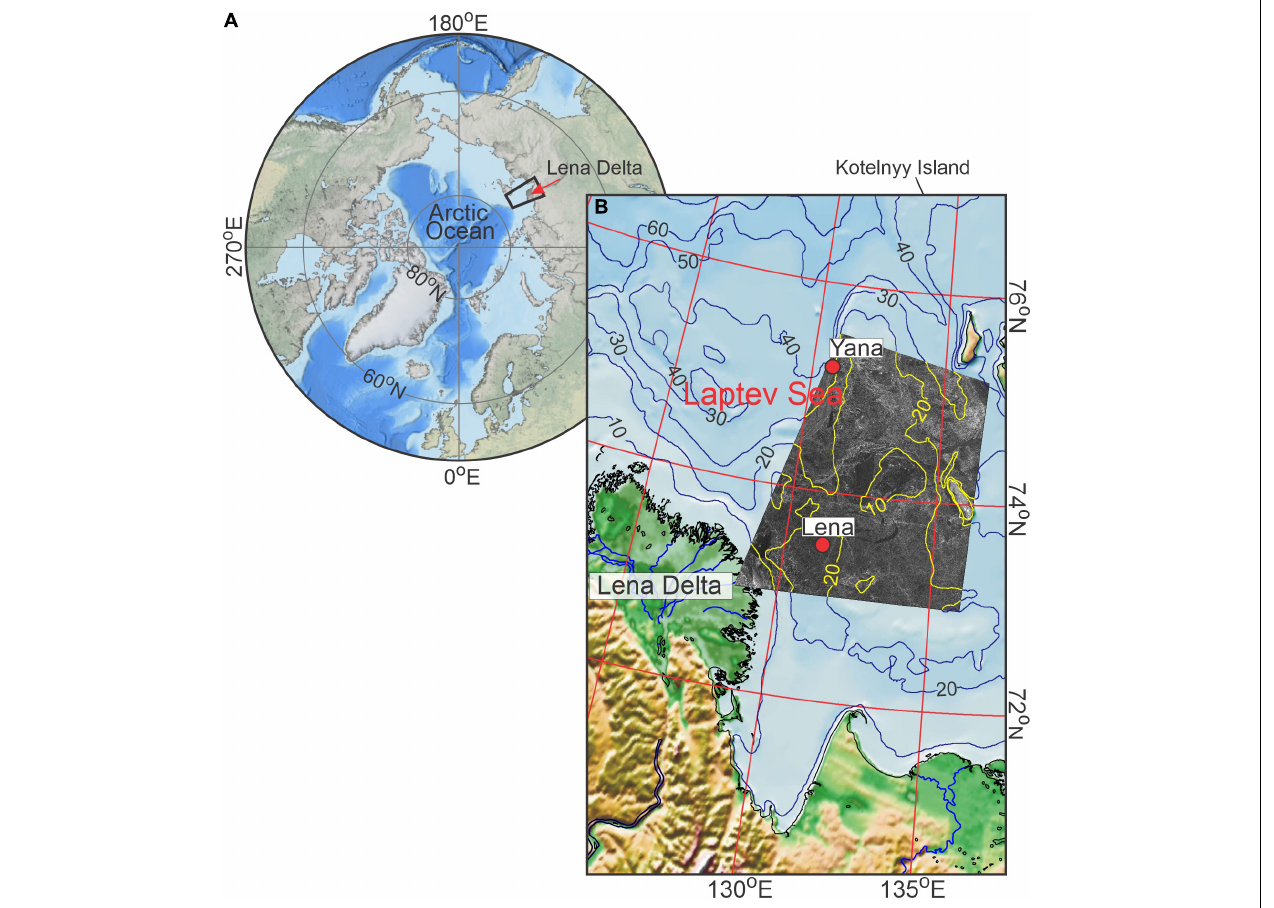
FIGURE 1 | (A) Location of the eastern Laptev Sea in the Arctic Ocean depicted by the black rectangle with the Lena River Delta indicated by the red arrow. (B) Bathymetry of the eastern Laptev Sea shelf with overlaid RADARSAT-1 satellite image from 26 March 1999. Red dots mark positions of yearlong (August 1998–1999) moorings Yana and Lena at 75 ◦ 09.01 (cid:48) N, 130 ◦ 49.94 (cid:48) E and 73 ◦ 27.37 (cid:48) N, 131 ◦ 41.98 (cid:48) E, respectively. The maps of the Arctic Ocean and Laptev Sea were compiled based on the International Bathymetric Chart of the Arctic Ocean Version 4.0 [General Bathymetric Chart of the Oceans (Jakobsson et al.,